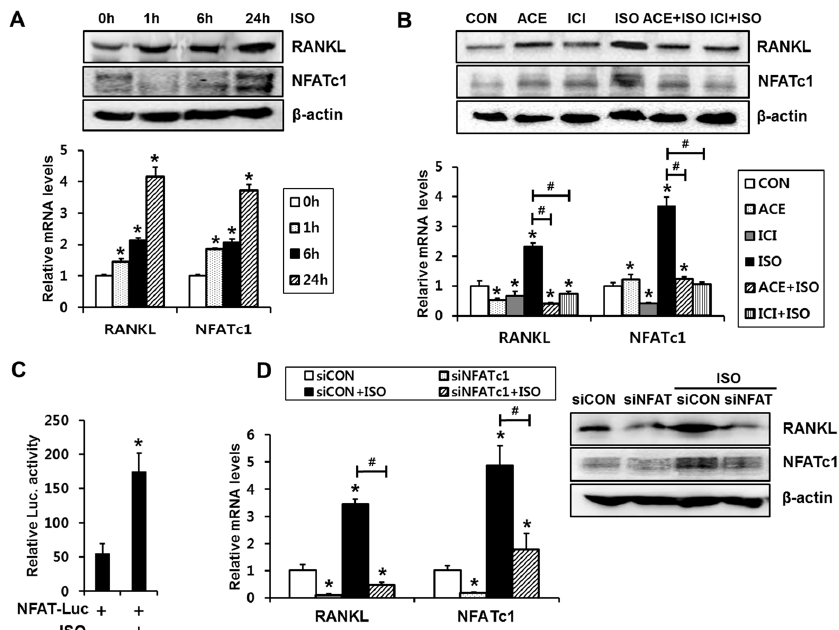
Figure 1. Isoproterenol induces expression levels and transcriptional activity of NFATc1, which is necessary for isoproterenol-induced RANKL expression. ( A ) Isoproterenol (ISO) increased the expression levels of RANKL and NFATc1. C2C12 cells were incubated in the presence of ISO at a concentration of 1 µM for the indicated time periods, followed by quantitative RT-PCR and Western blot analyses. * p < 0.05, compared to 0 h. ( B ) Both β 1 - and β 2 -adrenergic receptor subtypes were involved in ISO-induced RANKL and NFATc1 expression. C2C12 cells were treated with ISO for 24 h with the pretreatment of the selective β 1 - or β 2 -adrenergic receptor inhibitors (acebutolol (ACE), 1 µM; ICI-118551 (ICI), 1 µM), followed by RT-PCR and Western blot analysis. * p < 0.05, compared to CON. # p < 0.05, compared to ISO alone. ( C ) ISO-enhanced transcriptional activity of NFATc1. C2C12 cells were transfected with a reporter plasmid containing a NFAT response element (NFAT-Luc) and incubated for 24 h with or without ISO. * p < 0.05, compared to NFAT-Luc alone. ( D ) The knockdown of NFATc1 inhibited ISO-induced RANKL expression. C2C12 cells were transiently transfected with NFATc1 siRNA (siNFATc1) or non-targeting control siRNA (siCON) and incubated for 24 h in the presence or absence of ISO. Statistical significance was determined using one way ANOVA. * p < 0.05, compared to vehicle-treated siCON. # p < 0.05, compared to ISO-treated siCON. For all experiments, the quantitative data were presented as the mean ± SD.